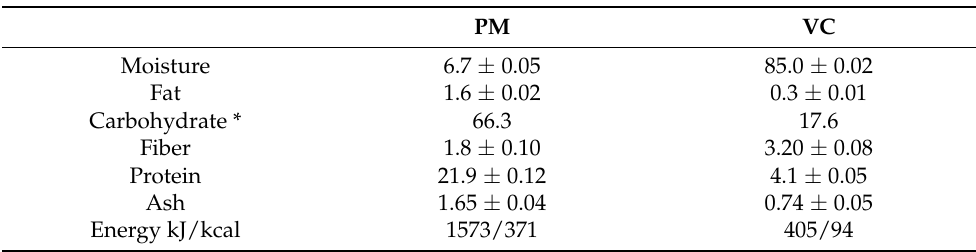
Table 3. Chemical composition (g/100 g) and energy value of innovative protein meal (PM) and vegetable cream